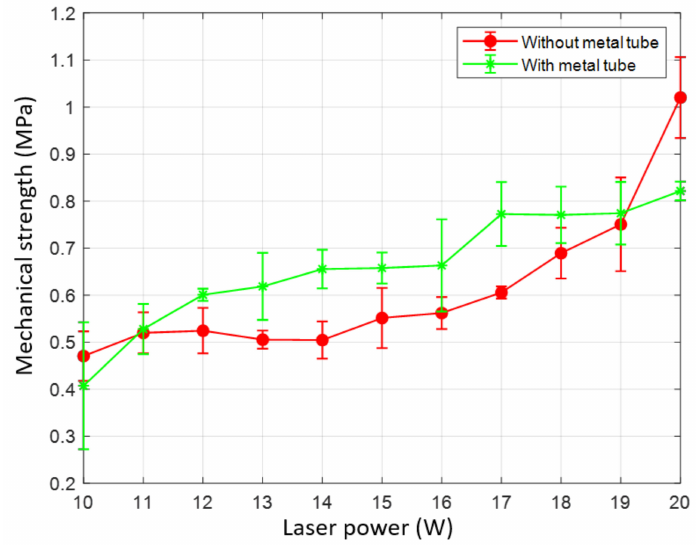
Figure 13. Tensile strength between the weld with and without the metal